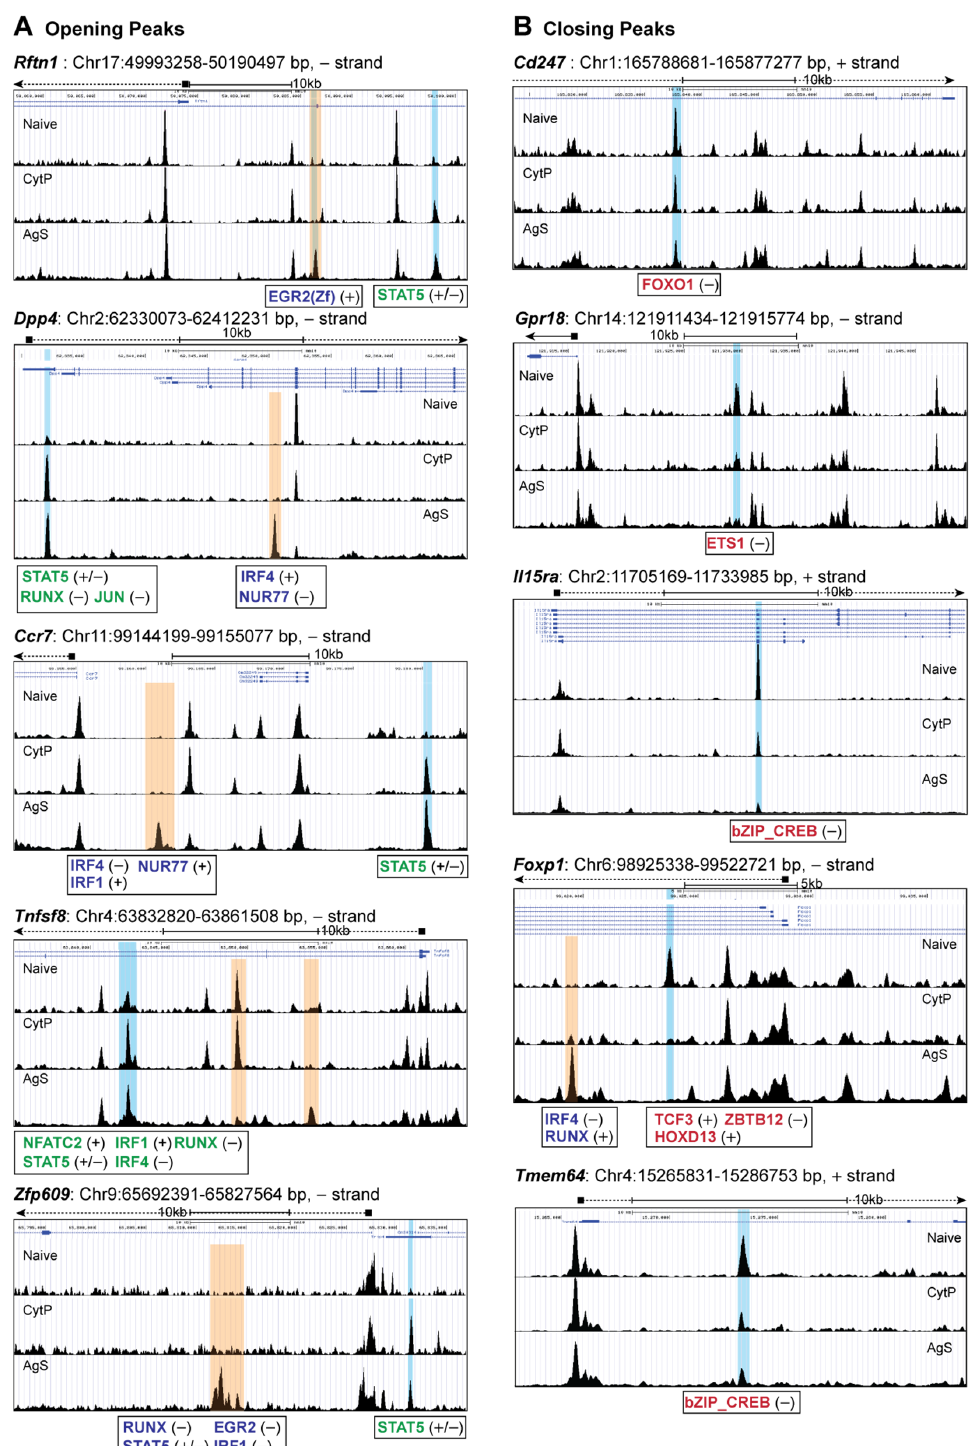
Figure 4. Chromatin accessibility in cytokine-primed cells. Genome browser snapshots of chromatin accessibility signal found in the opening ( A ) and closing ( B ) peaks of CytP cells that also occurred in AgS cells. Peaks modulated in both CytP and Ags cells are shaded blue, whereas those modulated only in AgS cells are shaded yellow. Color schemes for transcription factor binding motifs: green, in the opening peaks of CytP and AgS cells; red, in the closing peaks of CytP and AgS cells; blue, in the opening peaks of only AgS cells.